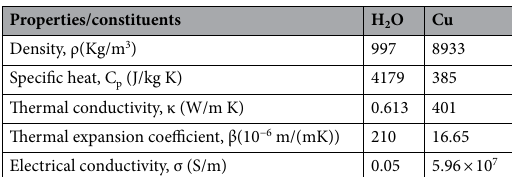
Properties/constituents